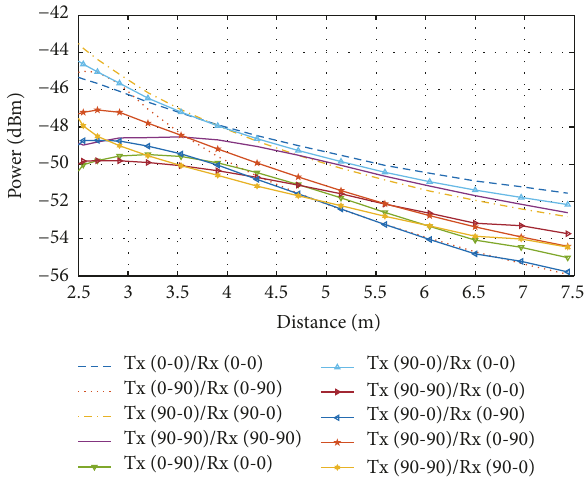
Figure 9: 𝑃𝑟 levels of all Tx and Rx combinations using the 3D cubic antenna in the LOS scenario.